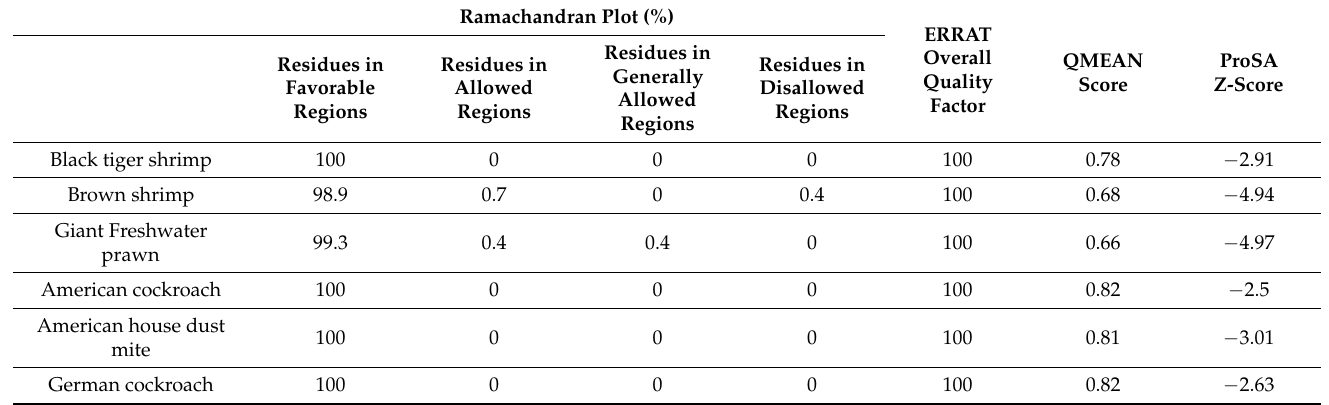
ProSA Z-ScoreResidues in